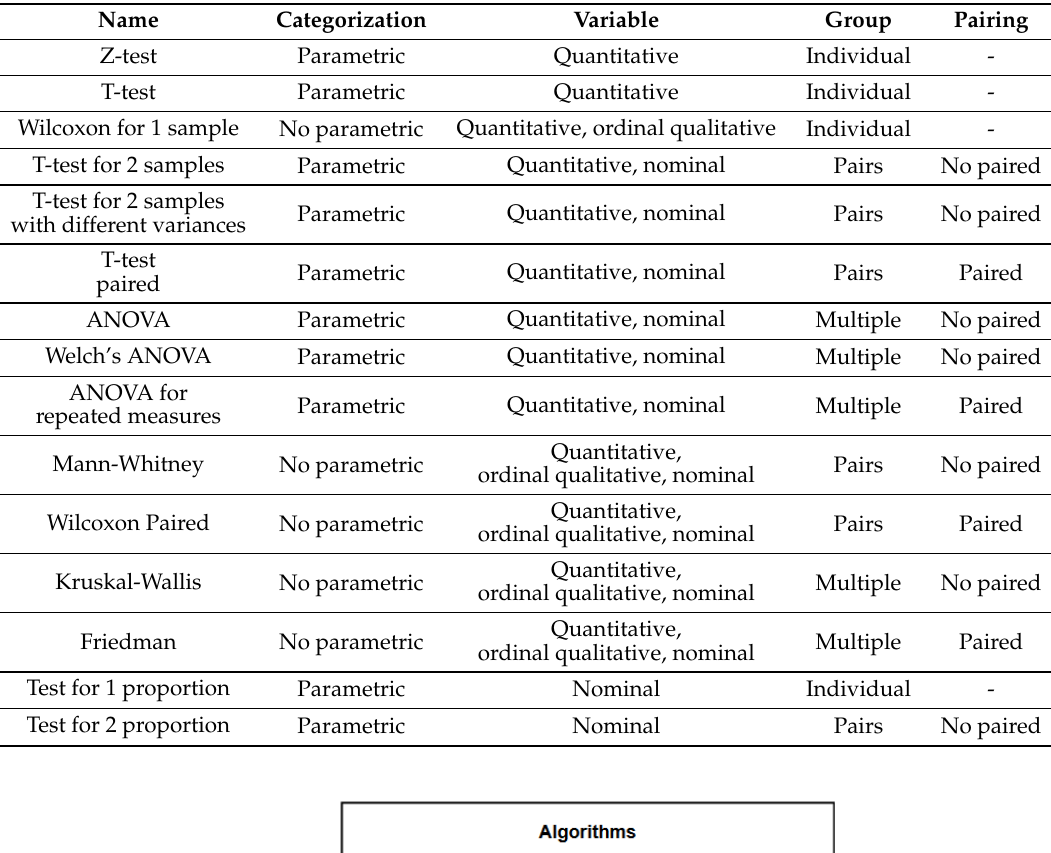
Table 2. Types of central tendency tests.